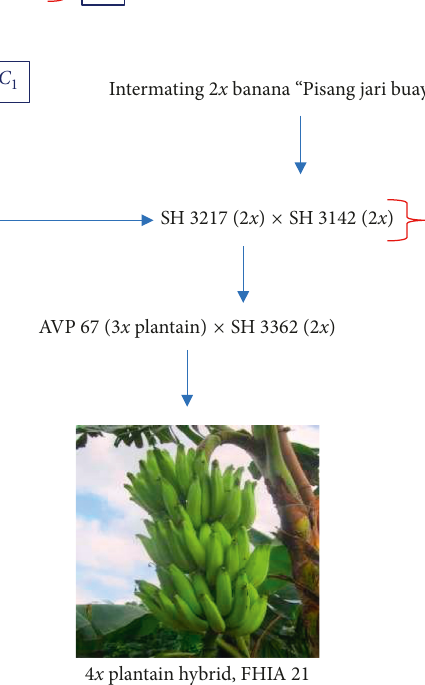
Figure 2: Development of primary tetraploid (4 x ) “FHIA 21” by FHIA, Honduras, which was, after further multilocation testing in West Africa, released as a new cultivar in Benin, Burkina Faso, Cˆote d’Ivoire, and Togo, as well as named “Apem hemaa” in Ghana. Its male diploid (2 x ) banana parent ensued after three cycles of phenotypic recurrent selection ( C i ) at 2 x ploidy level in Honduras with a germplasm influx from “Pisang jari buaya” in C 3 and interploidy crossing with triploid (3 x ) plantain AVP-67 (code for a plantain grown in Honduras and available at FHIA genebank). Source for pedigrees of 2 x bananas in C i : [25]. Although the year for each activity was unavailable, the timeframe from crossing ( C 0 ) in Honduras to release of FHIA 21 for worldwide distribution was about